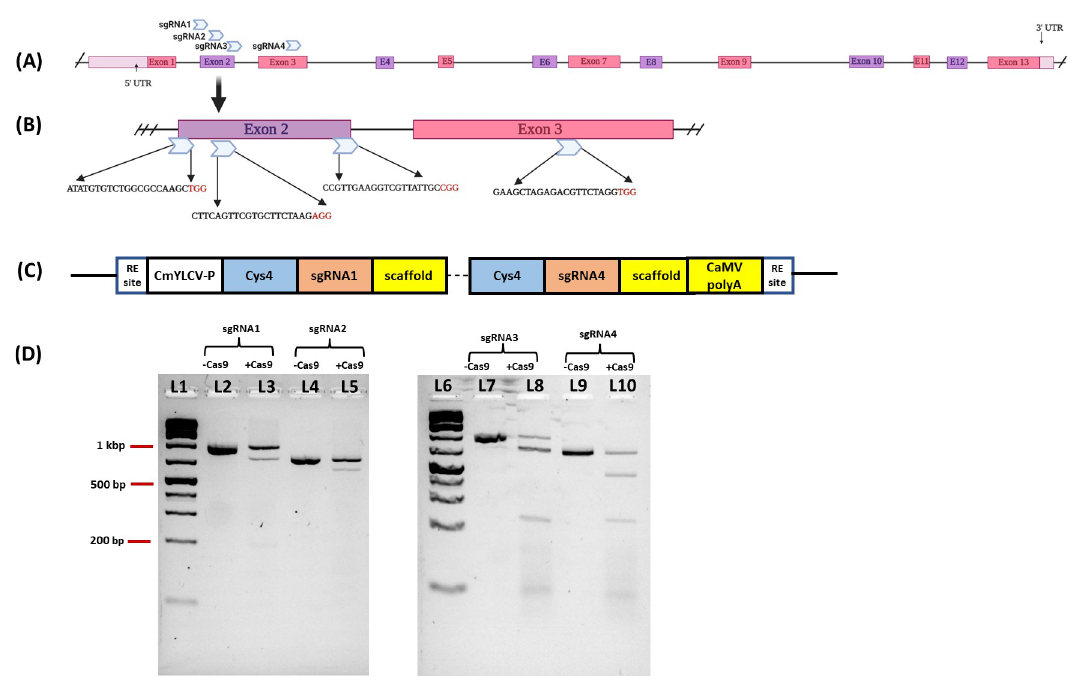
Fig 3. Details of the cowpea phytoene desaturase ( PDS ) gene. (A) Schematic representation of cowpea VgPDS gene. (B) Target region of PDS gene where four sgRNAs were designed. (C) Schematic diagram representation of cys4–sgRNAs cassette targeting the VgPDS gene. (D) In vitro digestion of VgPDS . Lanes L1 and L6: 1 kb Plus ladder, L2: uncut VgPDS target region, L3: VgPDS target region digested with Cas9 and sgRNA1 (expected bands of 753 bp and 218 bp), L4: uncut VgPDS target region, L5: VgPDS target region digested with Cas9 and sgRNA2 (expected bands of 648 bp and 130 bp), L7: uncut VgPDS target region, L8: VgPDS target region digested with Cas9 and sgRNA3 (expected bands of 741 bp and 230 bp), L9: uncut VgPDS target region, L10: VgPDS target region digested with Cas9 and sgRNA4 (expected bands of 524 bp and 254 bp) (partially designed with BioRender.com, accessed on 10 December 2022). Original gel images are provided as S1 Raw images.